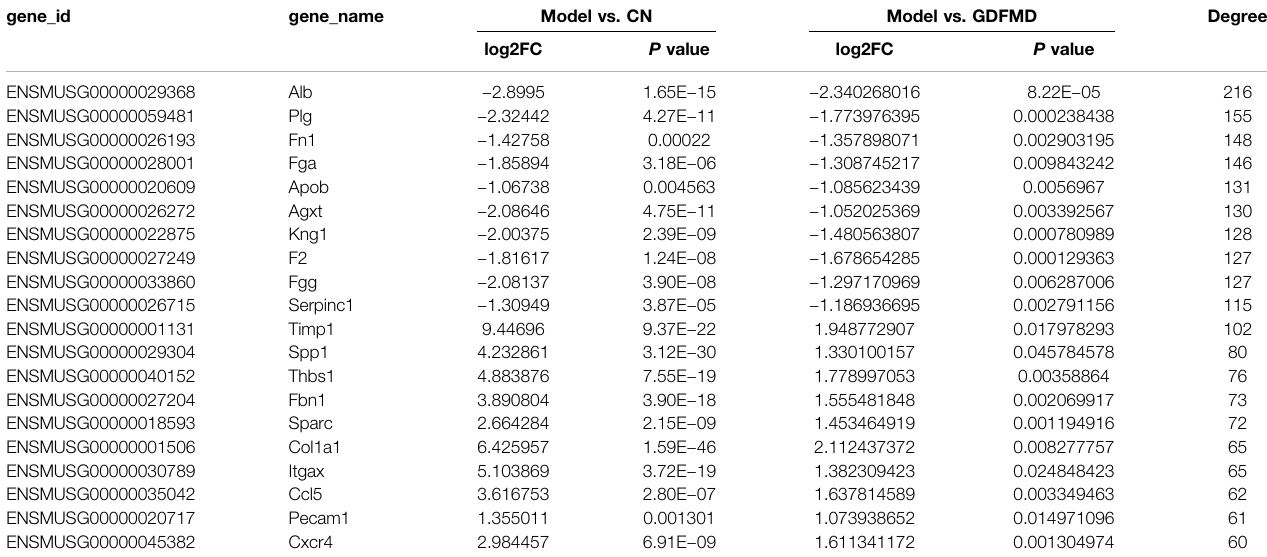
TABLE 2 | Top10 degrees of up- and down-regulated genes in WD. gene_id